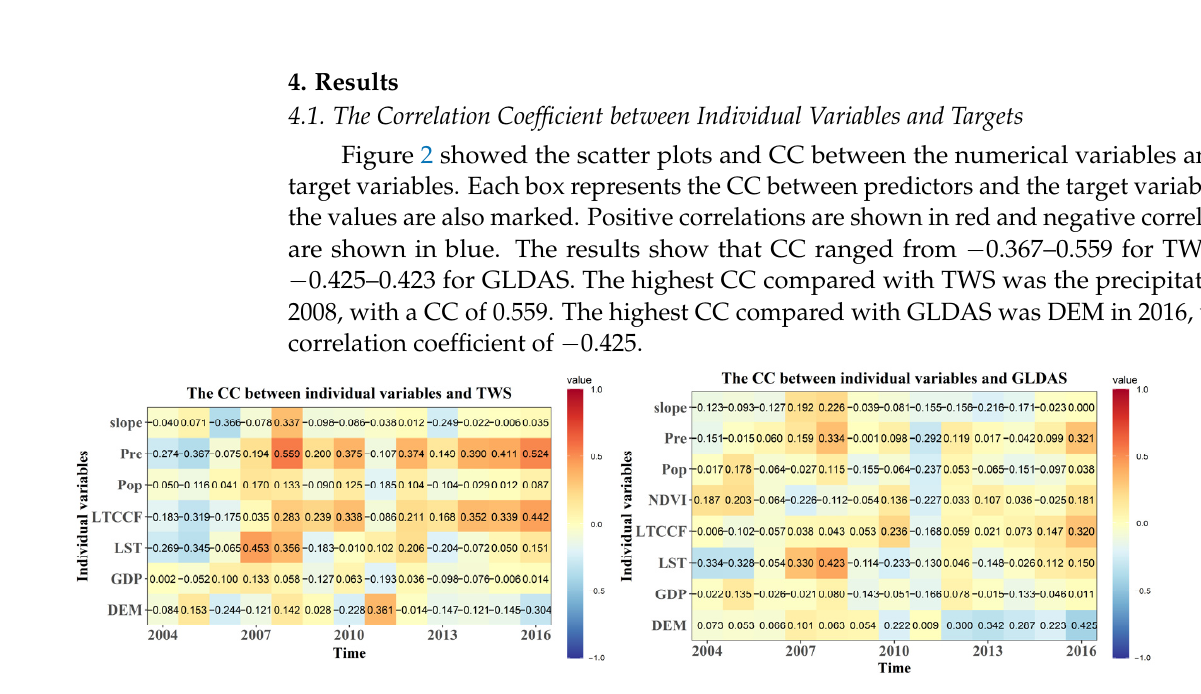
Figure 2. The correlation coefficient between individual variables and targets (the left for TWS and the right for GLDAS) from 2004–2016 except categorical